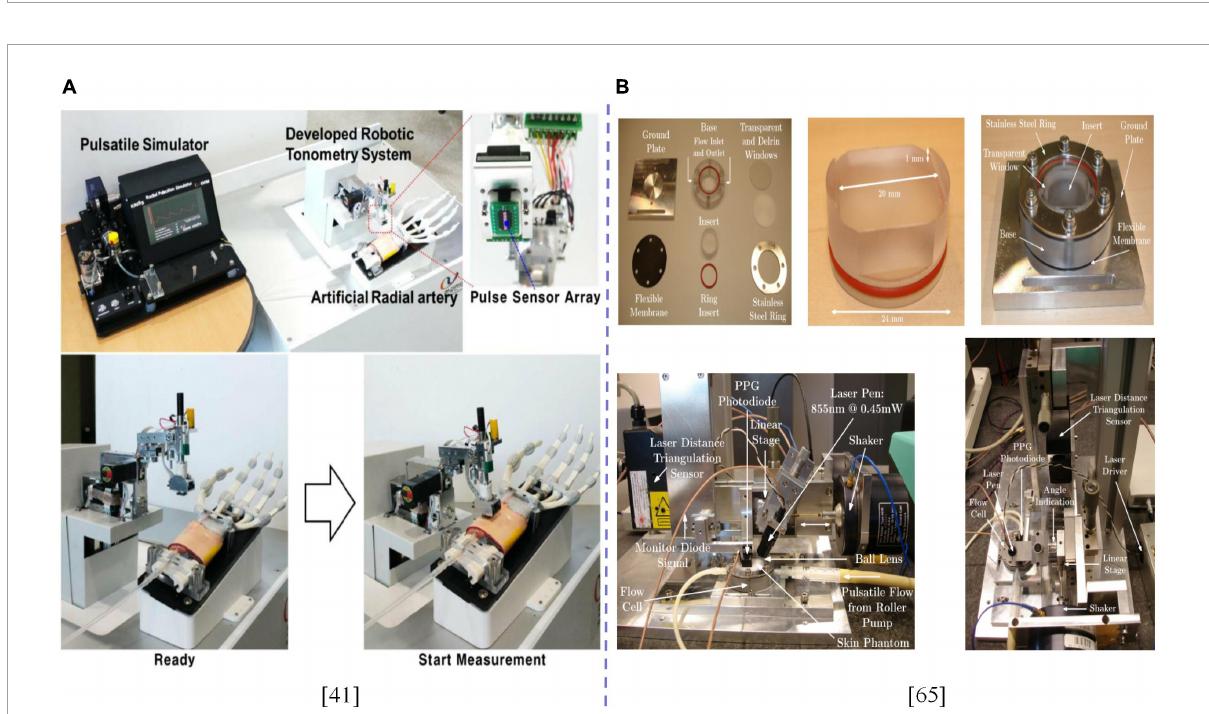
FIGURE3 (A) Experimental setup of a robotic applanation tonometry pulse sensor system for acquiring pulse signals from an artificial radial artery. (B) Experimental setup built to measure PPG distorted by optical motion artifacts in a controllable, reproducible manner. The dotted line is used to distinguish between different